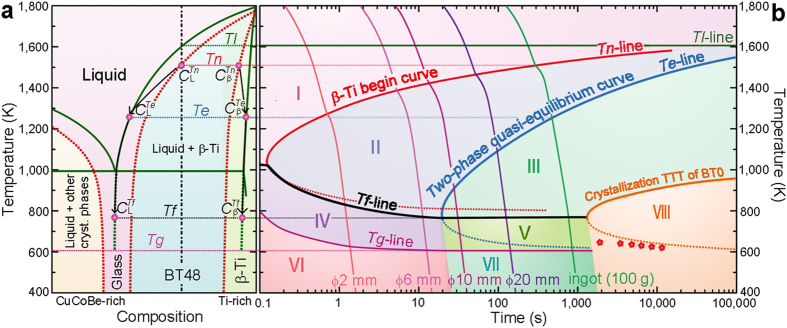
Schematic illustrations of the two-phase quasi-equilibrium.(a) Schematic binary phase diagram. The green solid lines represent the equilibrium liquidus line, the solution limit of β-Ti and the eutectic line. The left two red dashed lines describe the beginning stage at which β-Ti or other crystalline phases begin to precipitate in the undercooled melt at the cooling rate representing the ingot with a weight of 100 g. β-Ti begins to precipitate as the melt is cooled down and intersects the red dashed lines, and the composition of β-Ti is . It is slightly richer in solute (Cu and Co) than its equilibrium composition (the far right green line). For higher cooling rates, the degree of undercooling increases39 and thus the red dashed lines shift to lower temperatures. As the fraction of β-Ti increase, the compositions of both phases change from  to . When the quasi-equilibrium is established between the (undercooled) liquid and β-Ti, the compositions of both phases change along the liquidus and the solution limit of β-Ti (green lines) from  to . (b) Schematic continuous cooling transformation curves (CCT) for BT48. The β-Ti begin curve (Tn–line), the two-phase quasi-equilibrium curve (Te–line), and the crystallization TTT curve of BT0 are drawn between their Tl and Tg, respectively. () are DSC measured times before crystallization of BT0 plus (2000 K-990 K)/(1 K s−1). The cooling curves starting from 2000 K are indicated by the different sample diameters (calculated from equation (2)). Phases in regions with different colours are: I, liquid; II, liquid + β-Ti (non-equilibrium compositions, changeable microstructure); III, liquid + β-Ti (equilibrium compositions, changeable microstructure); IV, supercooled liquid + β-Ti (non-equilibrium compositions, unchangeable microstructure); V, supercooled liquid + β-Ti (quasi-equilibrium compositions, unchangeable microstructure); VI, non-equilibrium BMGCs; VII, quasi-equilibrium BMGCs; VIII, crystallized matrix + β-Ti. If cooling curves intersect Te–line (not crystallization curve of BT0), quasi-equilibrium BMGCs will be achieved, otherwise, non-equilibrium BMGCs will be obtained. The sketches of thermodynamic views are shown in Supplementary Fig. 2.